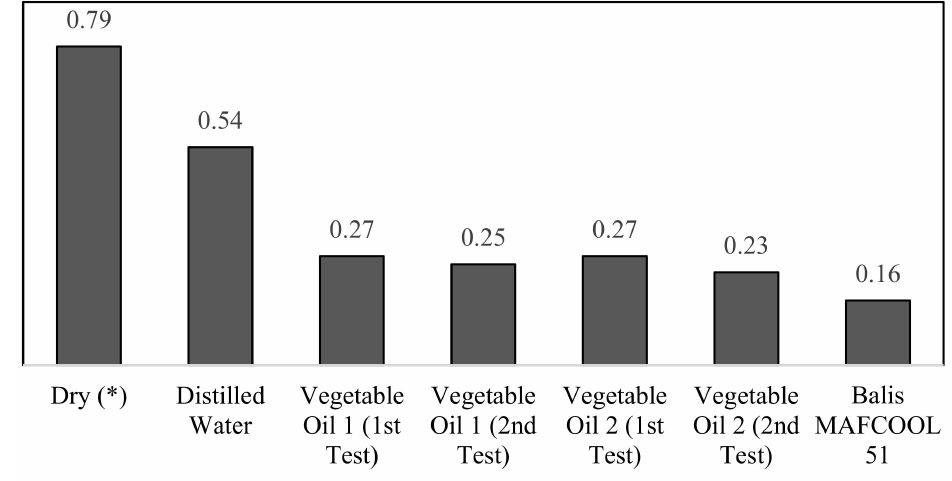
Figure 12. Friction coefficient values in steady-state regime for sliding contacts between an alumina ball and 316L stainless steel for different lubricant conditions (W = 5 N; v = 0.5 m/s).